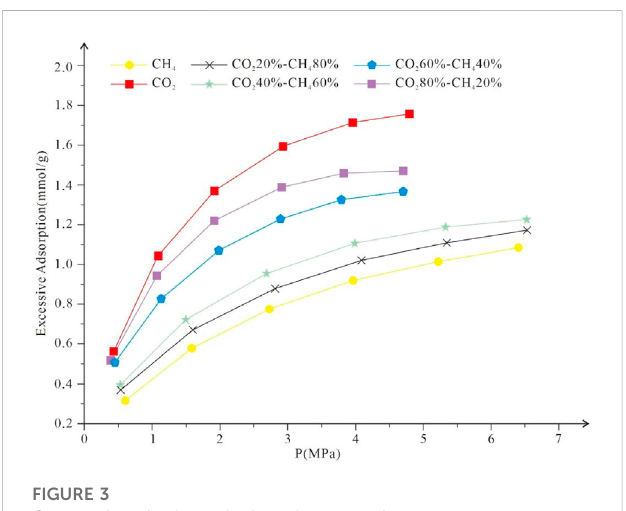
FIGURE 3 Curves of gas isothermal adsorption on